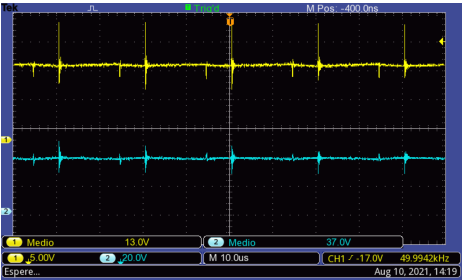
Figure 15. Capacitor voltages: capacitor C i ( Top ) and capacitor C 1 ( Bottom ).